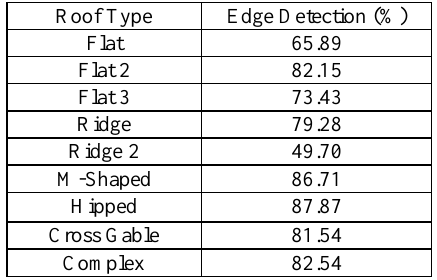
Table 1. Percentage of edges detected compared to manually